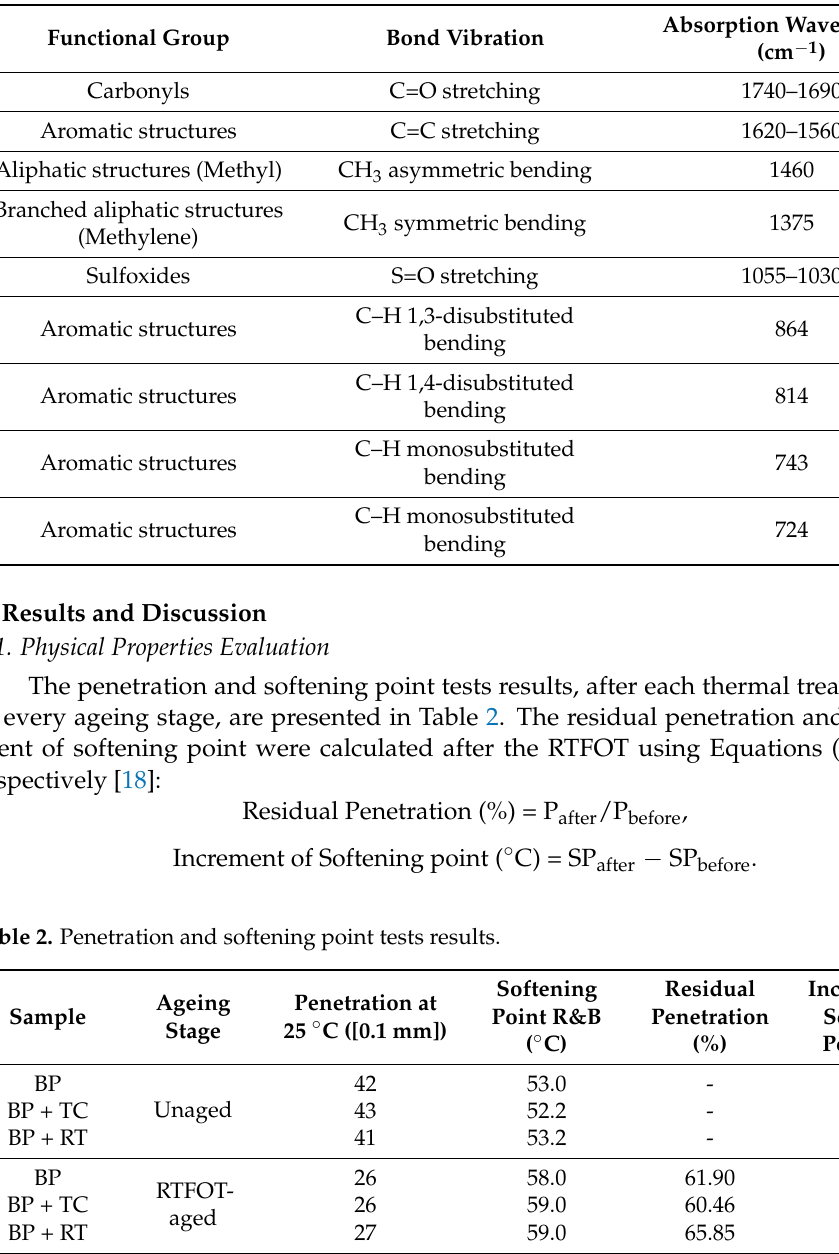
Table 1. Absorption wavenumbers of functional groups in bitumen.